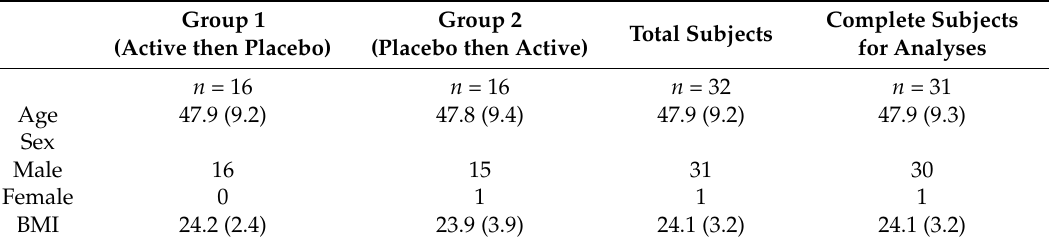
Table 2. Characteristics of the